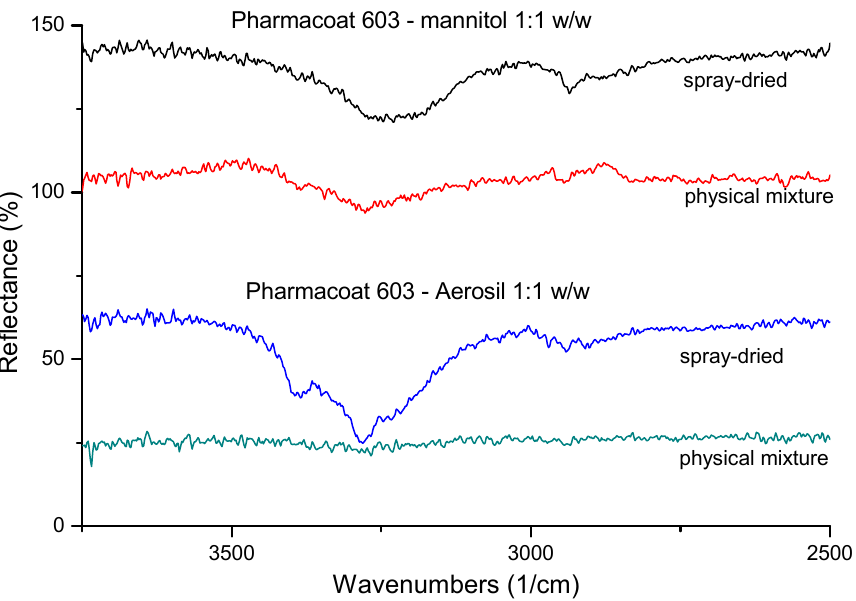
Figure 3. Representative ATR-FTIR spectra of 1:1 w / w physical mixtures of Pharmacoat 603 with mannitol and Aerosil before and after spray-drying.